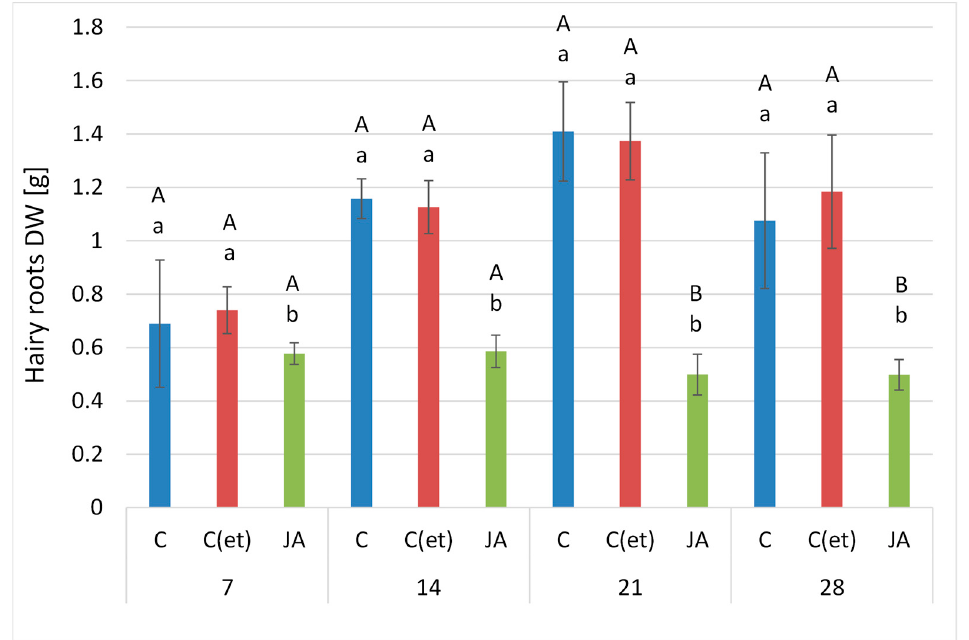
Figure 1. Time-dependent effect of jasmonic acid on hairy root biomass. C—control, C(et)—control samples supplemented with 70% ethanol, JA—jasmonic acid-elicited samples. Bars which do not share a common letter are significantly different. Capital letters indicate significant difference in time between plants from the same treatment, lowercase indicate difference between treatments within certain time point.